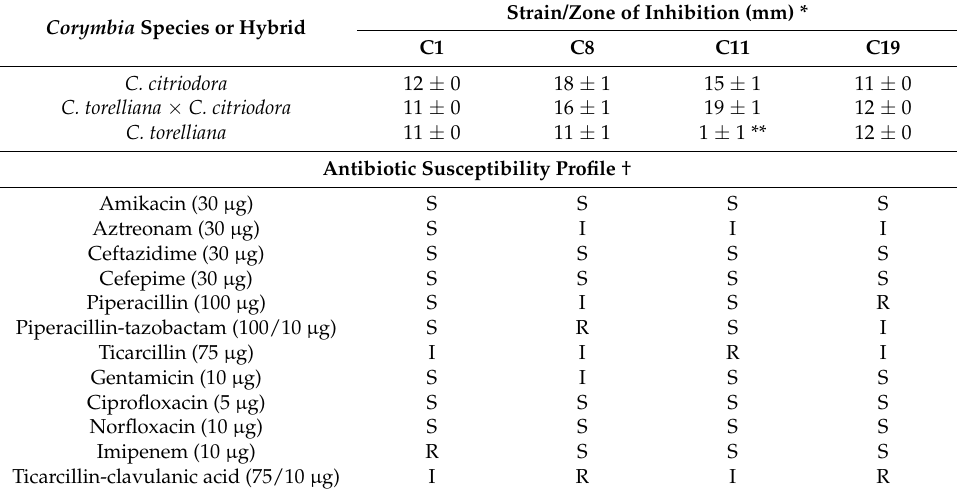
Table 1. Antimicrobial activity of a 1.0% (v/v) solution of kino extract from Corymbia citriodora , C. torelliana × C. citriodora , or C. torelliana against four clinical strains of Pseudomonas aeruginosa (C1, C8, C11, and C19) representing different clonal types . Antibiotic susceptibility profile of isolates is also